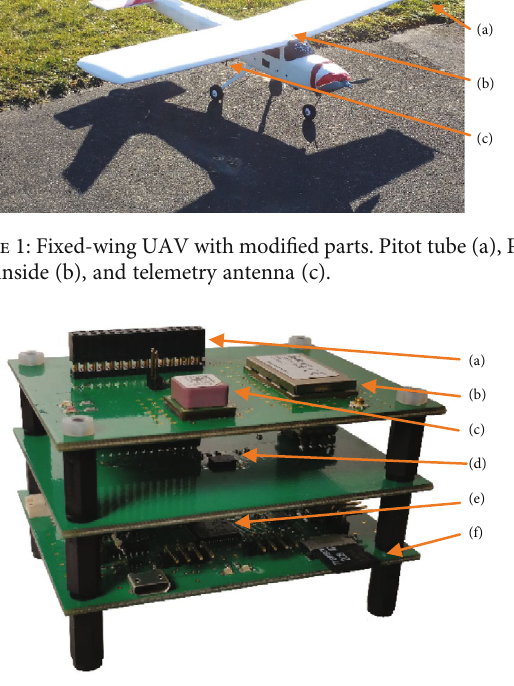
Figure 2: Printed circuit boards are stacked and interconnected with a 30-pin header. 30-pin header (a), telemetry (b), GNSS (c), IMU (d), μ C (e), and SD card